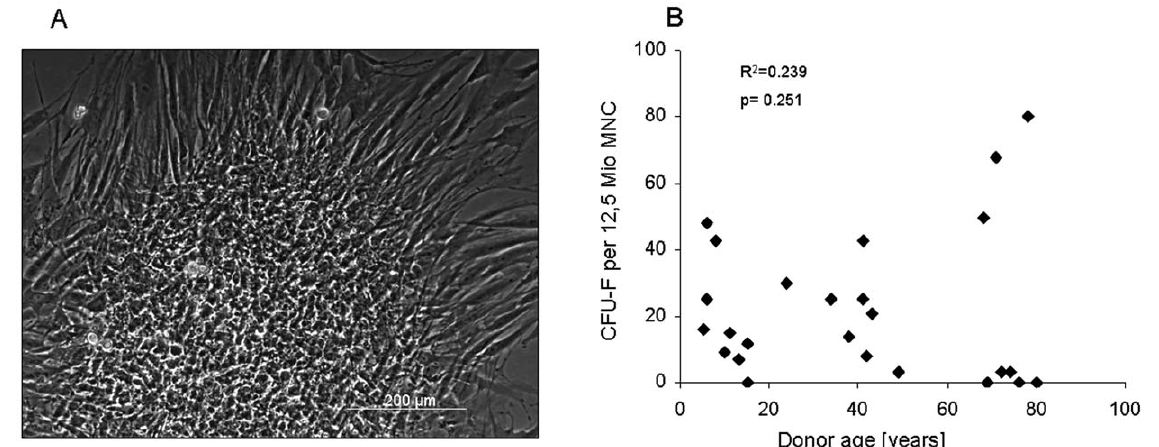
Figure 1. Number of Colony-forming units per mononuclear cell fraction of bone marrow aspirates. Seven days after initial seeding of 5 6 10 5 mononuclear cells (MNC) per cm 2 , obtained spots of mesenchymal stem cells (MSC) were counted as one CFU-F (A) if the cluster consisted of more than 30 cells. (B) No correlation was obvious between the number of CFU-F and donor age. Correlation was calculated by Spearman-Rho Test.